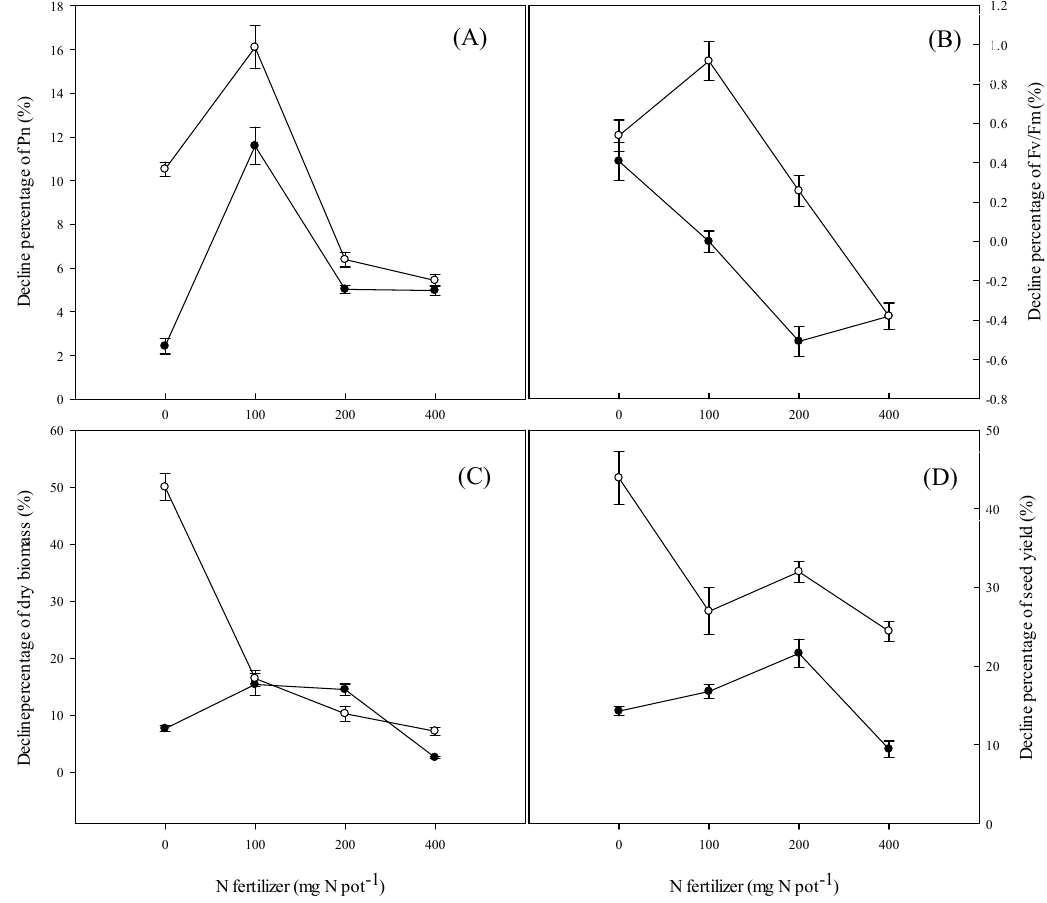
Figure 2. Alleviation of nitrogen fertilization on the decline percentage (compared to the non-saline control treatment) of photosynthetic rate ( A ), PSII maximum quantum efficiency ( B ), dry biomass ( C ) and seed yield ( D ), by saline soil treatment. The black circle represents genotype SA and the white circle represents genotype ND. Table 1. Summary of analysis of variance for the photosynthetic rate (Pn), stomatal conductance (g s ), and transpiration rate (E) at the flowering stage in the first run of a controlled greenhouse study. Source of